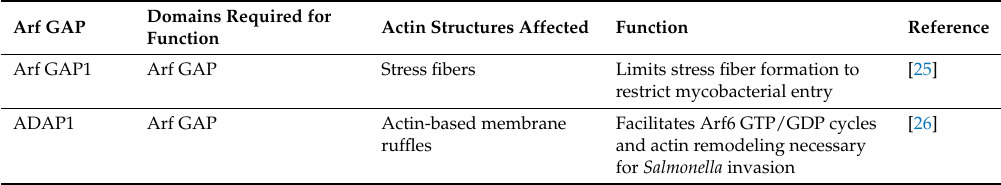
Table 1. Arf GAP-dependent actin structures and associated